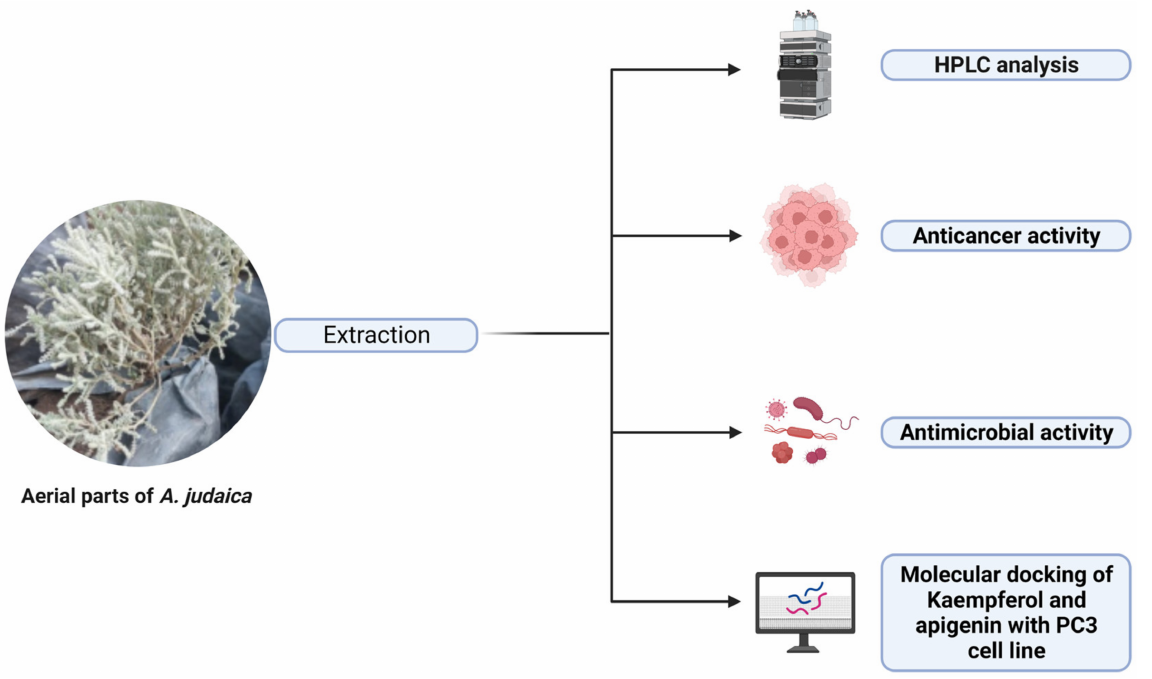
Figure 1. Image showing aerial parts (above the soil) of Artemisia judaica (plant), which underwent successful extraction methods and multiple relevant assays to determine the phytochemical, antimi- crobial, and antitumor activities of the extracted product. This figure was created with